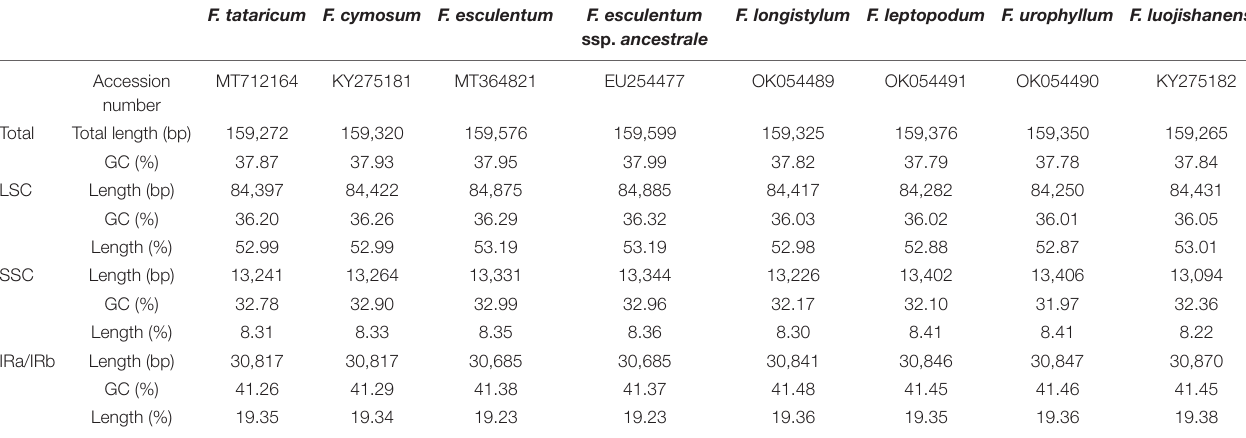
TABLE 1 | Comparison of the complete chloroplast genomes for eight Fagopyrum